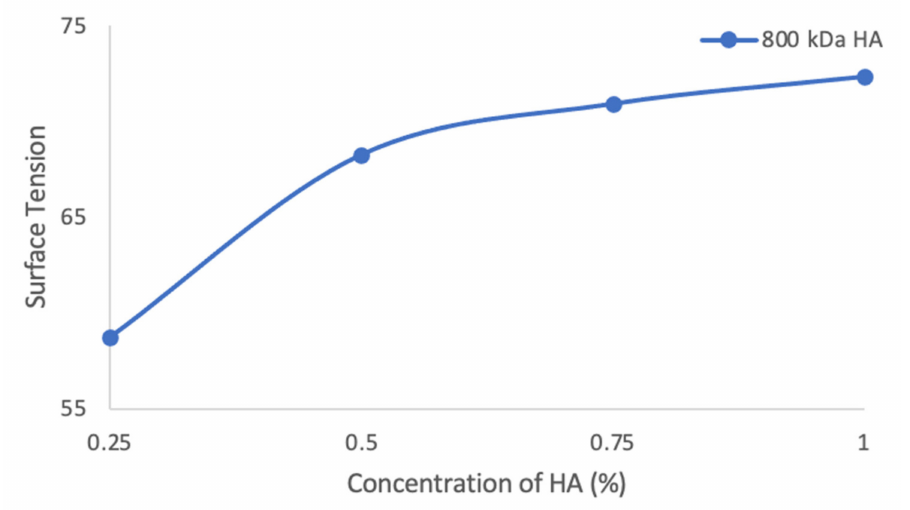
Figure 7. Effect of HA concentration on surface